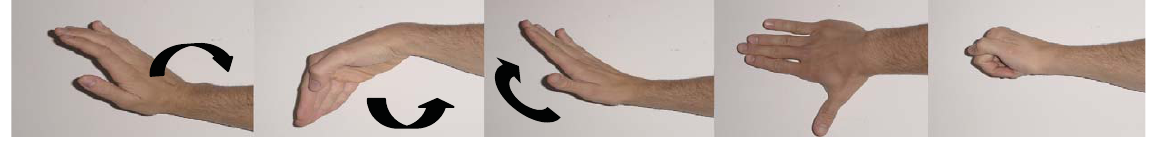
Fig. 3. The five movements to discriminate: wrist extension and flexion, thumb flexion, hand opening, hand closing.